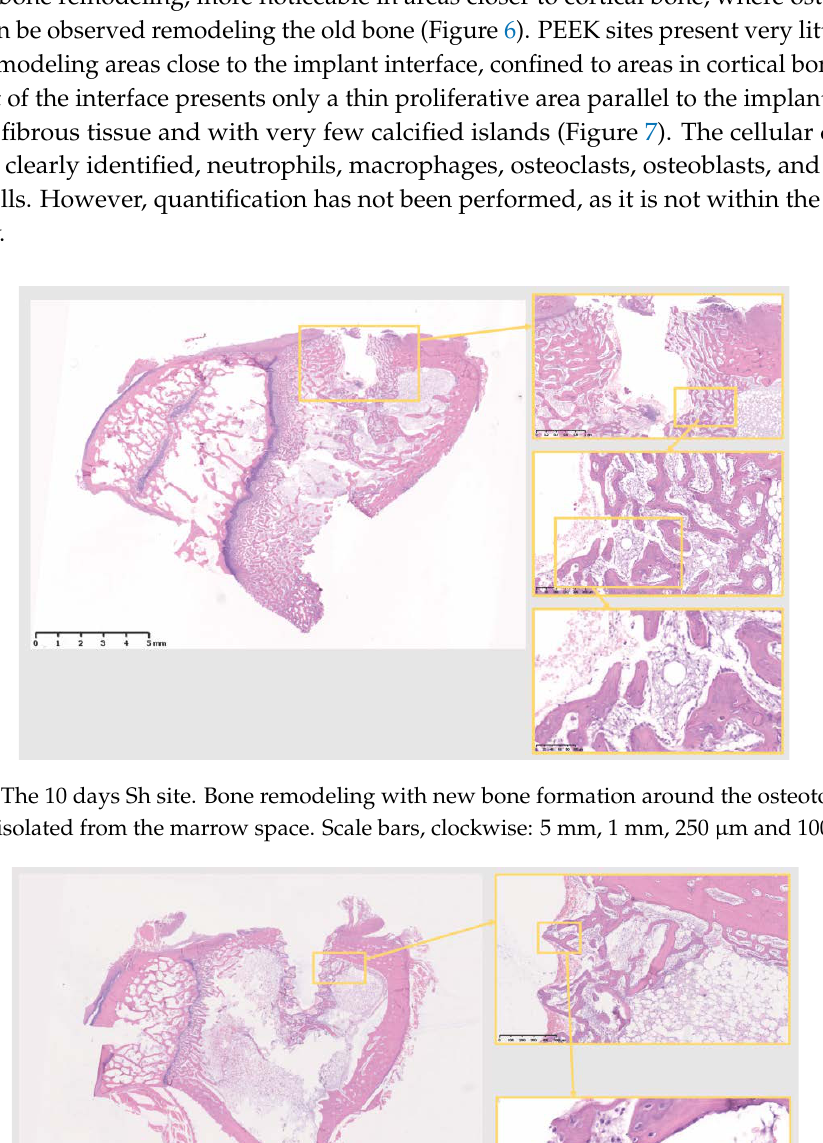
Figure 6. The 10 days Cu site. No bone on the immediate implant vicinity. FBGC, foreign body giant cells; Oc, osteoclast actively remodeling old bone; Ob, Seam of osteoblasts producing new bone (part of the remodeling); IO, Implant/Osteotomy. Reaction to Cu divided in 3 zones, representing the 3 phenomena around implant materials in the bone: From the implant surface Lytic/Inflammatory area, Fibroproliferative area and Osteoproliferative area. The latter two represent an attempt to isolate the material from the marrow cavity. No osseointegration is viable at this time point. Theoretically, around Ti the same phenomena exist, but at a different balance, allowing for osseointegration, through direct bon-to-implant contact. Inflammatory area is highly vascularized. Scale bars 5 mm (left) and 100 µm (right). Figure 7. The 10 days PEEK. NB, new bone; forming only in the areas adjacent to cortical bone, while most other interfacial tissue shows no bone formation. P, proliferative area; no visible calcified tissue